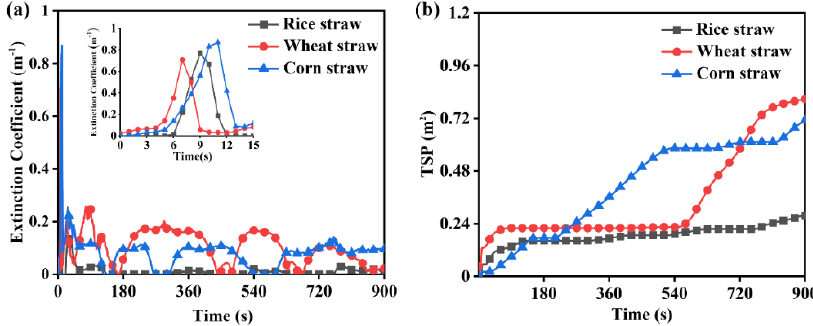
Figure 3. K curves ( a )and TSP curves ( b ) of the three crop straws at 50 kW/m 2 .